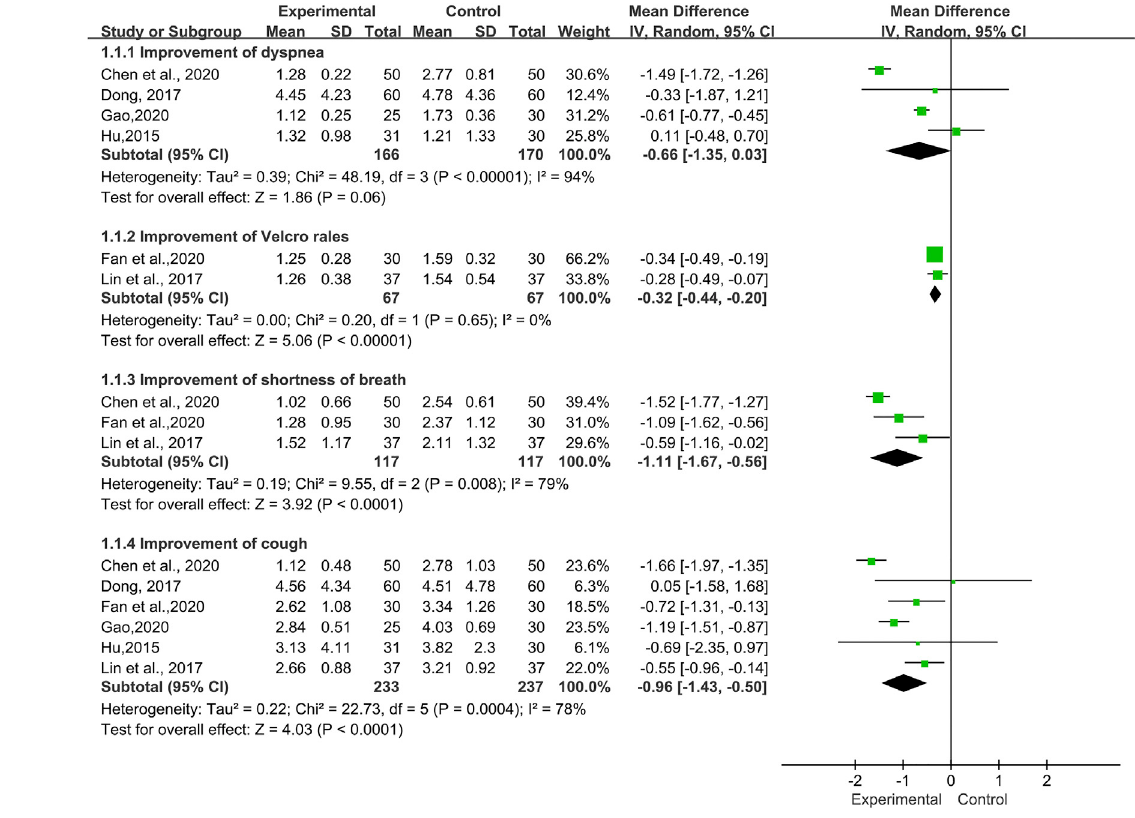
FIGURE 6 | Forest plot of improvement of symptoms and signs with TwHF combined with conventional treatment versus pure conventional treatment.